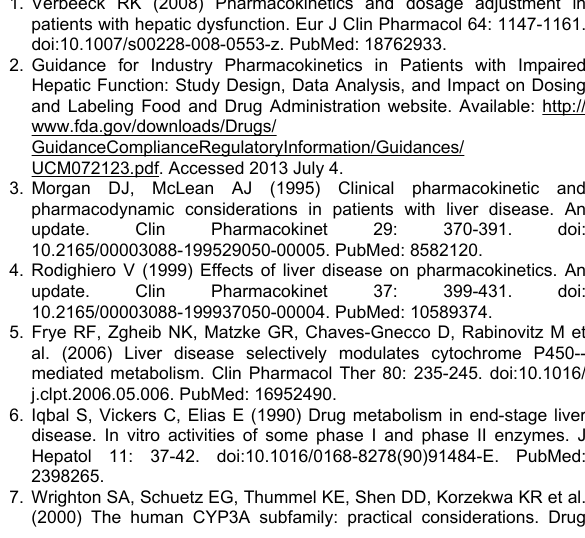
Figure 3. Block diagram showing the distribution of miRNA binding sites in the 3’ Untranslated regions (UTR) of the CYP3A4 transcripts. UTR regions of the both the transcripts ENST00000354593 (length 1172 bp) and ENST00000336411 (474 bp) are aligned to the left and shown from 5’ to 3’ orientation. When multiple miRNAs were found to overlap in their binding locations on the respective transcripts, different tracks are used to improve the layout.